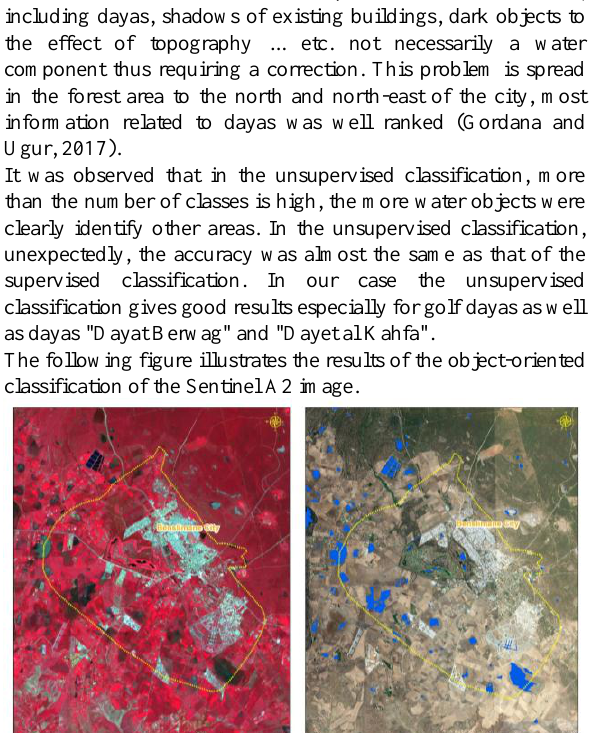
Figure 7. Extraction of dayas by different methods used in this study